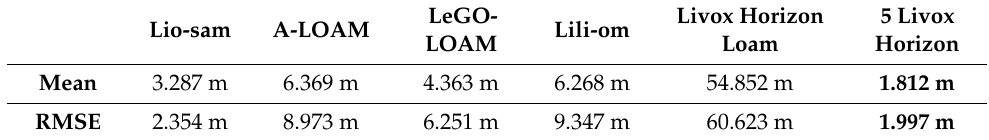
Table 1. Horizontal position error statistics of the big loop. (Compared with Velodyne VLP-16).